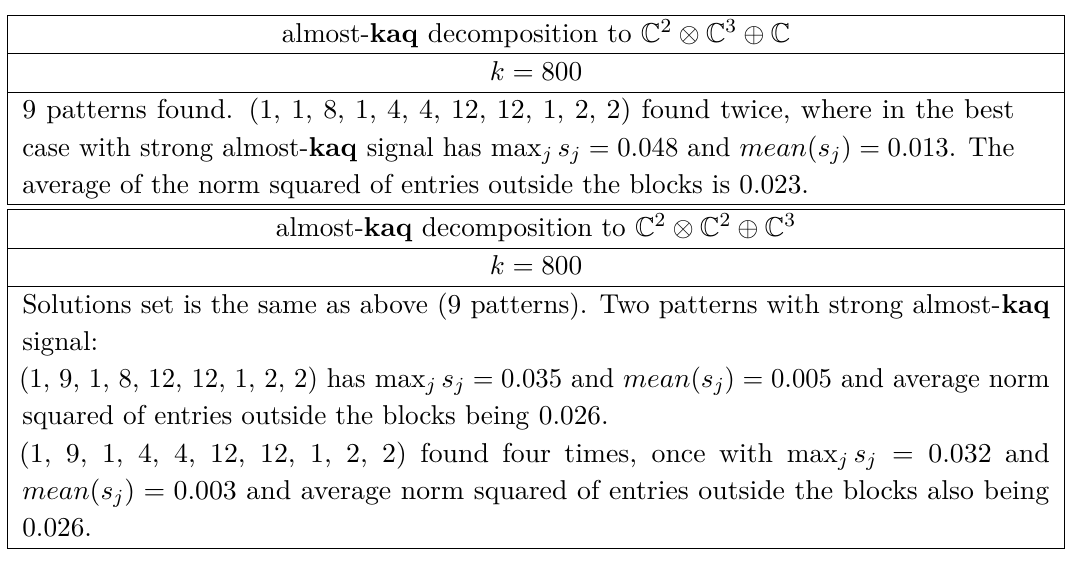
Table 6 . Almost- kaq ness for L 24 on su (7) . Note that the average of a random entry from an l 2 -normalized 7 × 7 matrix is 0 . 02 (to be compared with above). Note that there are 24 entries outside the 7 × 7 matrix blocks for C 2 ⊗ C 2 ⊕ C 3 decomposition, and 12 for C 2 ⊗ C 3 ⊕ C .